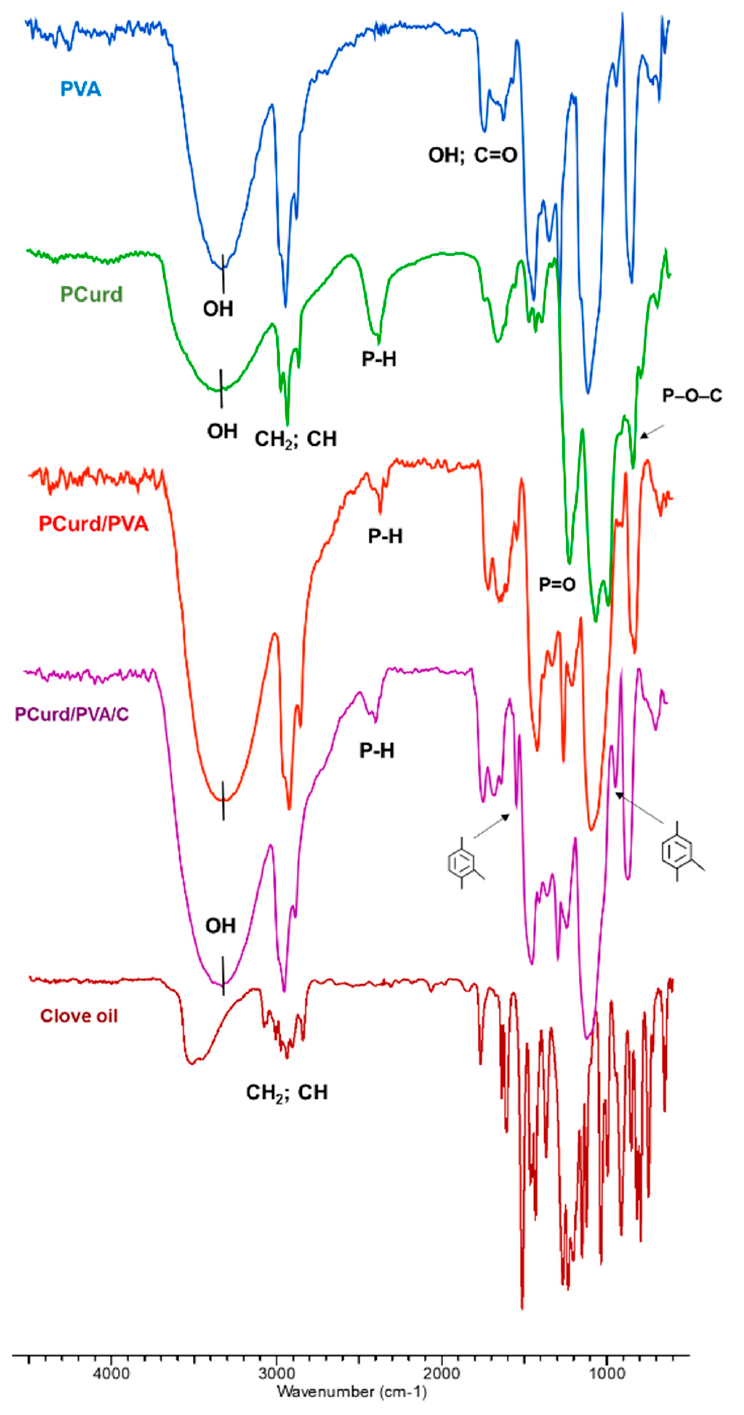
Figure 2. The ATR spectra of the nanofibre membranes with and without incorporated CEO (PCurd/PVA, PCurd/PVA/C) together with the polymeric components and the therapeutic oil. SEM micrographs of the electrospun membranes obtained from PVA and